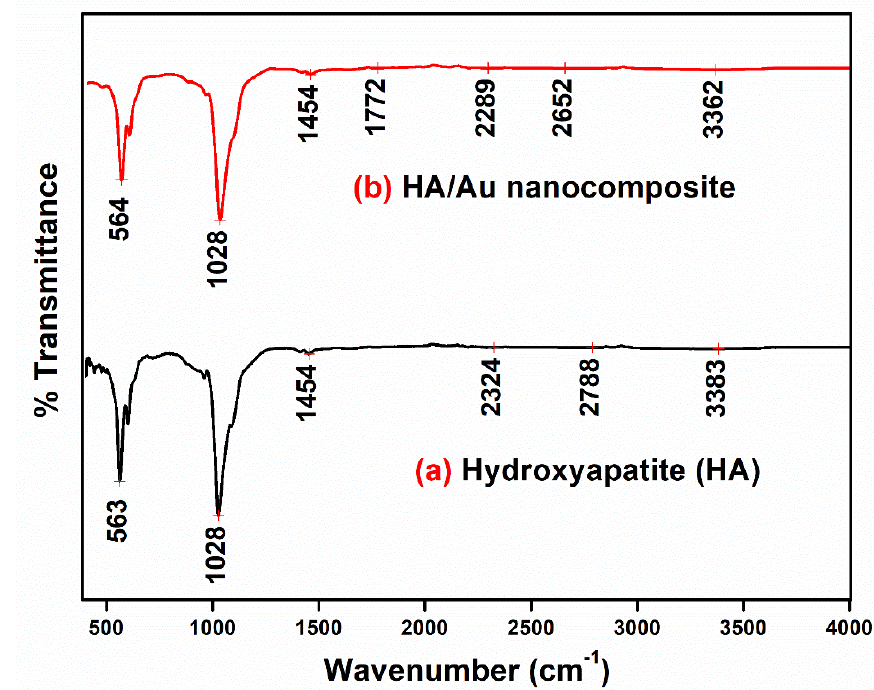
Figure 3. FTIR spectra of ( a ) pure HA and ( b ) HA/Au nanocomposite.